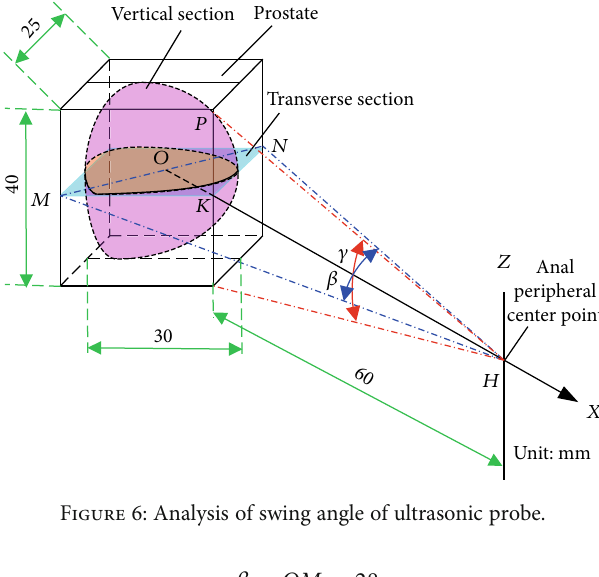
Figure 6: Analysis of swing angle of ultrasonic